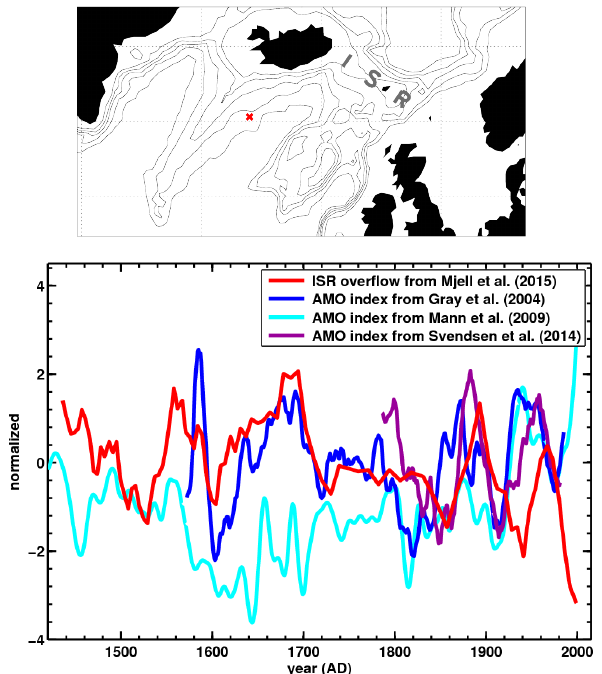
Figure 1. Reconstructed AMO index from Gray et al. (2004, blue), Mann et al. (2009, cyan) and Svendsen et al. (2014, pur- ple); Iceland–Scotland overflow strength from Mjell et al. (2015, red). The AMO indices are shown as annual values with an 11- year running mean filter applied. For the Iceland–Scotland over- flow strength, the original time series has irregular dates and is smoothed by applying a three-point running mean filter. All time se- ries are normalised by the respective standard deviations. The map shows the location of the sediment core on which the reconstructed Iceland–Scotland overflow strength is based (topography is shown for depths of 500, 1000, 1500, 2000 and 2500m). Figure adapted from Mjell et al.